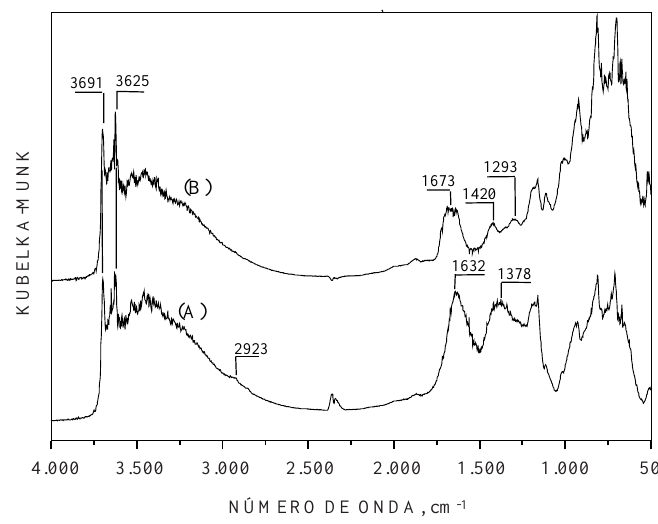
Figura 1. Espectros de DRIFT do Cambissolo Húmico na forma natural (A) e oxidada